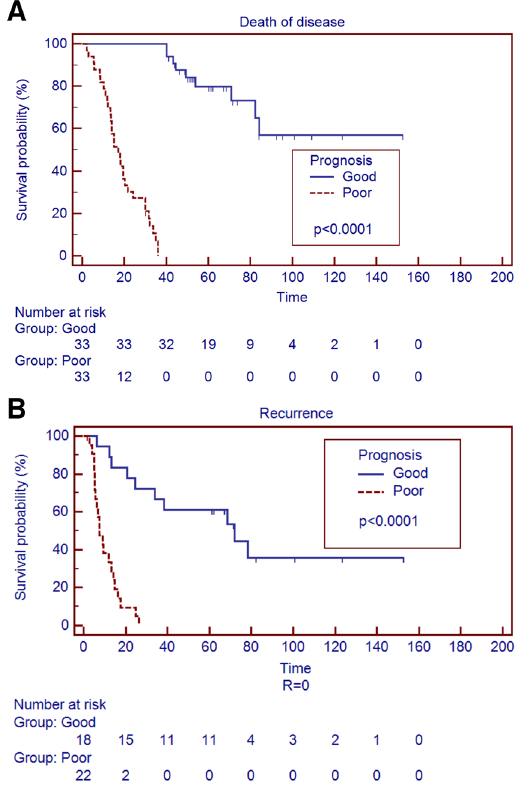
Figure 1. Grouping according to prognosis of 66 intrahepatic cholangiocarcinomas. ( A ) Overall survival significantly divided 66 intrahepatic cholangiocarcinoma in two prognostic performers group according to clinical outcome ( p < 0.0001). ( B ) Prognostic grouping also divided intrahepatic cholangiocarcinomas characterized by negative resection margins in two different groups ( p <